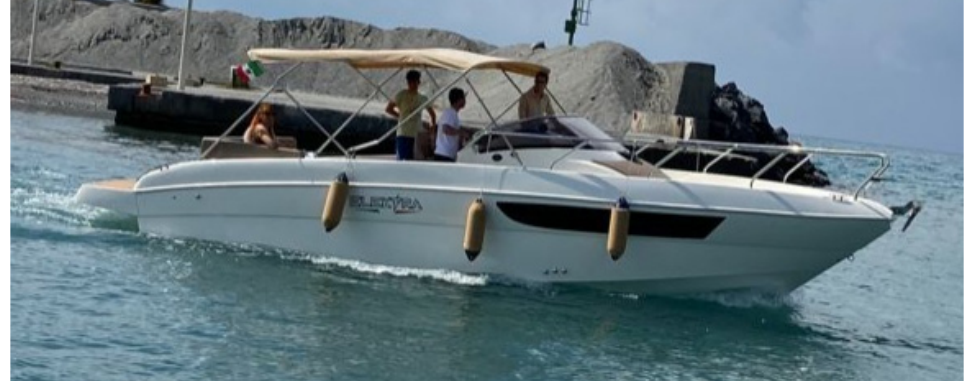
Figure 14. KISS prototype in the zero-emission mode.